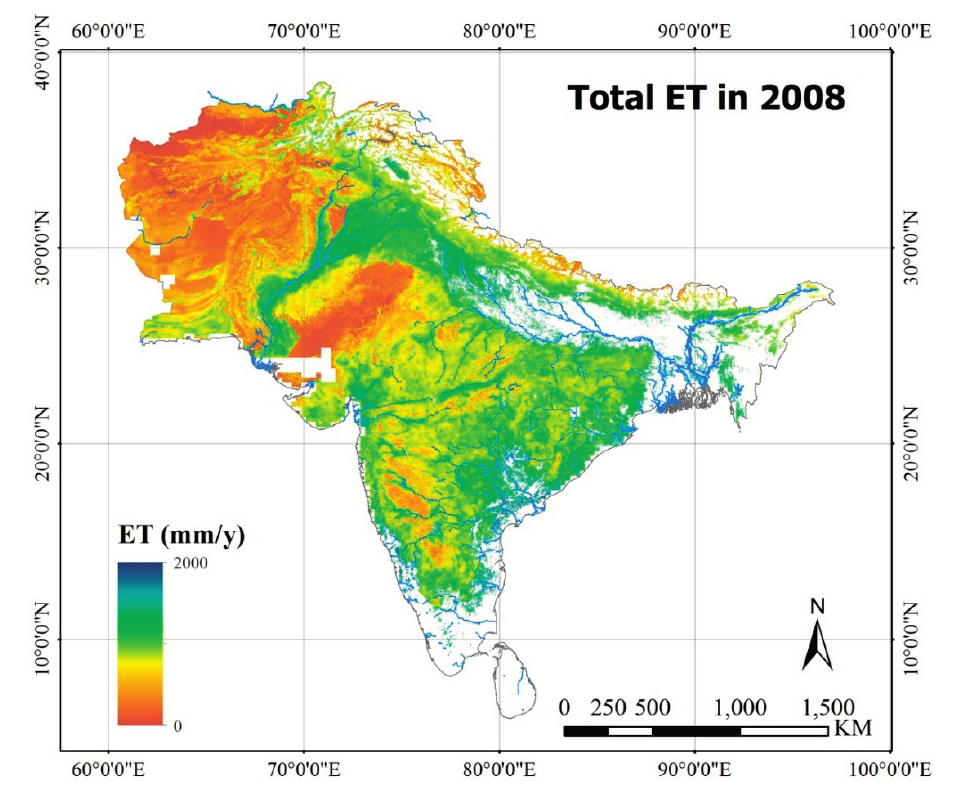
Figure 10. Annual ET spatial distribution in 2008 in South